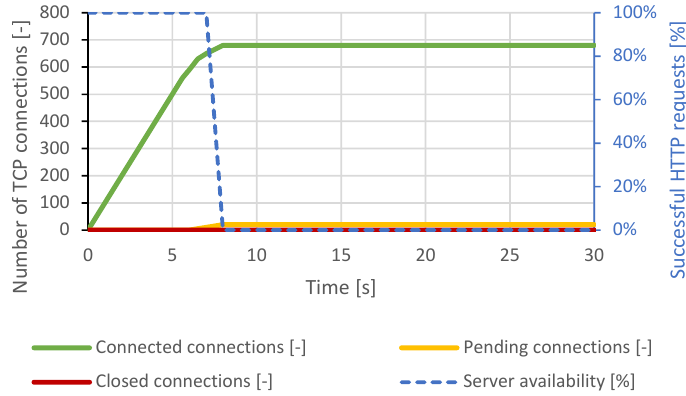
Figure 7. Slow Next attack against Apache